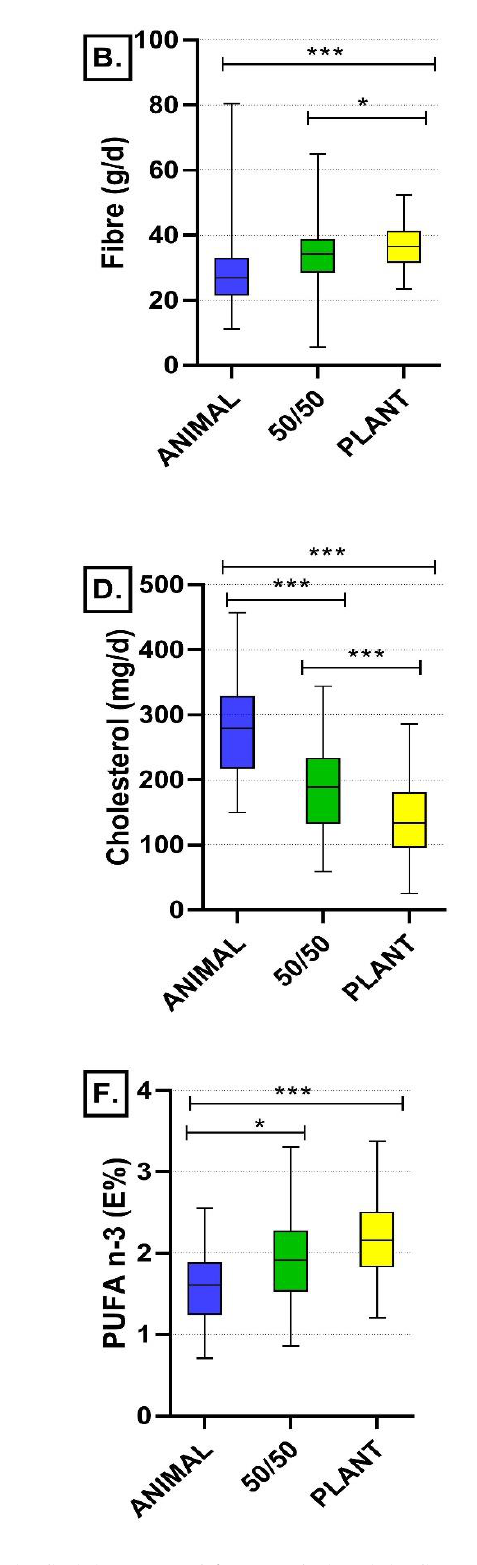
Figure 2. Endpoint intakes of ( A ) protein (E%), ( B ) fibre (g / d), ( C ) saturated fatty acids (SFA) (g / d), ( D ) cholesterol (mg / d), ( E ) polyunsaturated fatty acids (PUFA) (E%), and ( F ) n-3 polyunsaturated fatty acids (PUFA n-3) (E%) in the diet groups. Differences between the diet groups analysed by ANOVA with Bonferroni correction: * p < 0.05, ** p < 0.01, *** p < 0.001.